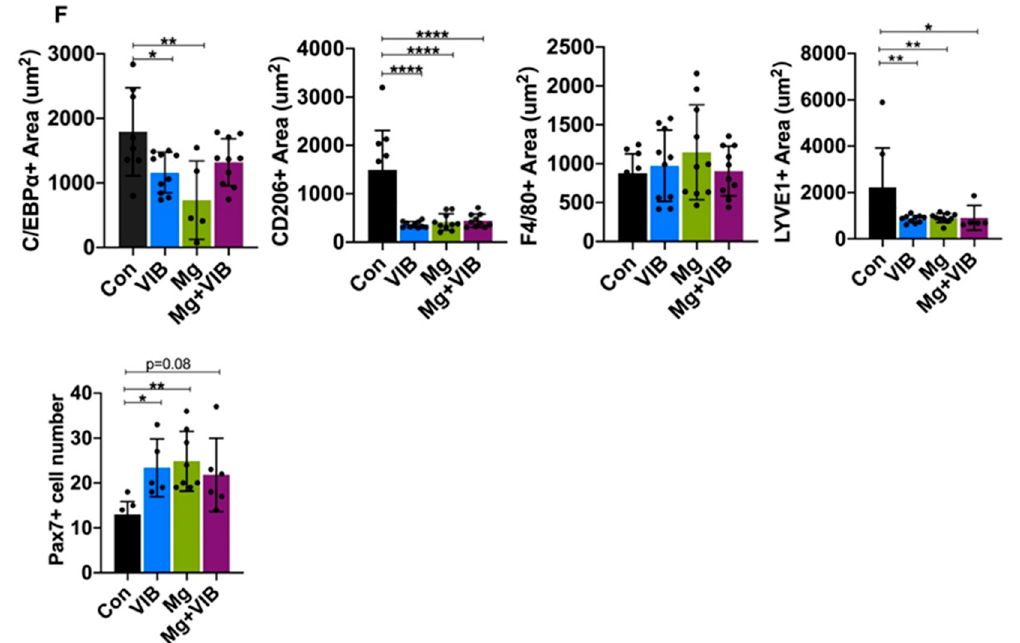
Figure 4. Immunohistochemical staining of inflammatory markers and M1/M2 macrophage in different groups at month 4 post treatment. White arrow showed the positive area. ( A ) At month 10, the Mg group showed a significantly lower positive area of C/EBP α staining area than the Con group ( p < 0.01). The C/EBP α positive area in the VIB group and the Mg + VIB group were lower than in the Con group, without significance. ( B ) CD206 positive areas in all treatment groups were significantly lower than in the Con group. ( C ) The F4/80 positive area showed no significant changes among all groups. ( D ) VIB, Mg and Mg + VIB groups showed significantly lower LYVE1 positive areas than the Con group at month 10. ( E ) PAX7-positive cell numbers in the VIB and Mg groups were significantly higher than in the Con group. ( F ) Quantification results of C/EBP α , CD206, F4/80, LYVE1 positive area and PAX7-positive cell number. Scale Bar: 10 μ m. * p < 0.05, ** p < 0.01, and **** p < 0.0001, n = 5–10.